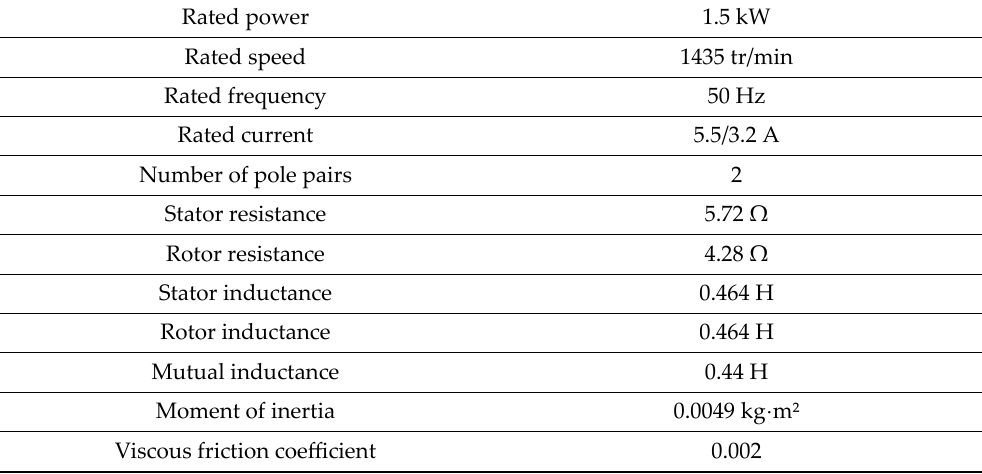
Table A1. The three‑phase induction motor’s parameters in SI units, used for simulations, are listed